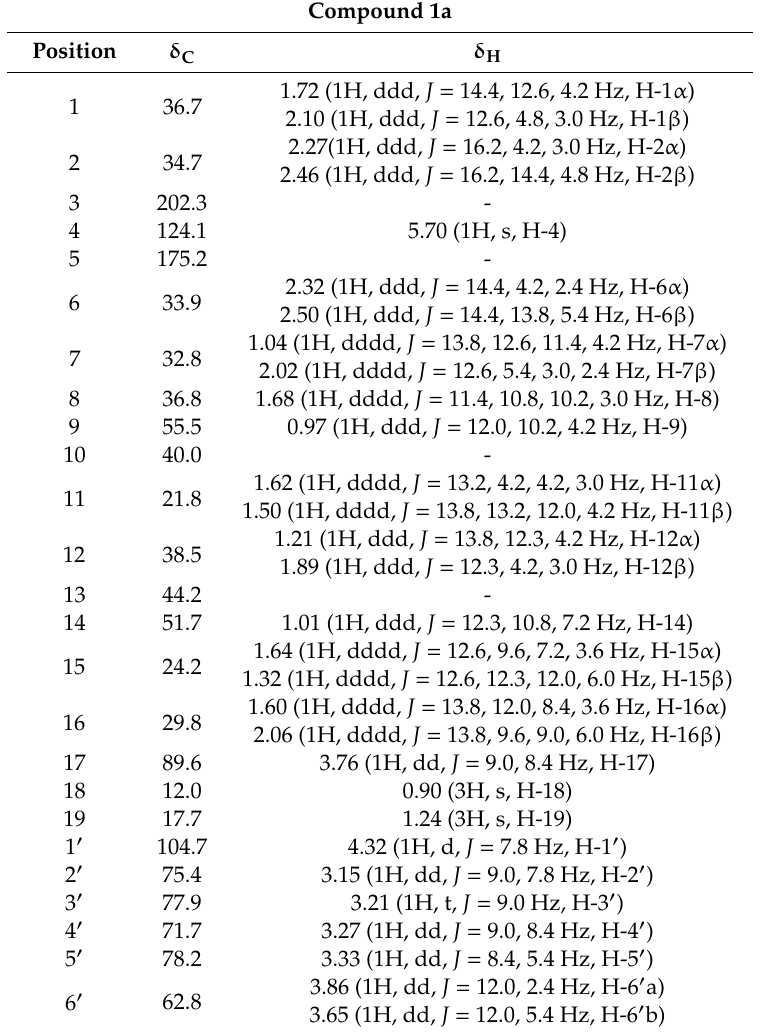
Table 1. NMR spectroscopic data for compound 1a (T-17-G), in CD 3 OD ( δ in ppm, J in Hz).